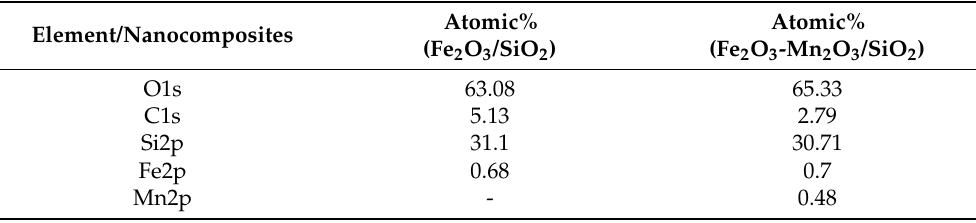
Table 1. Atomic ratio of elements used in the synthesis of